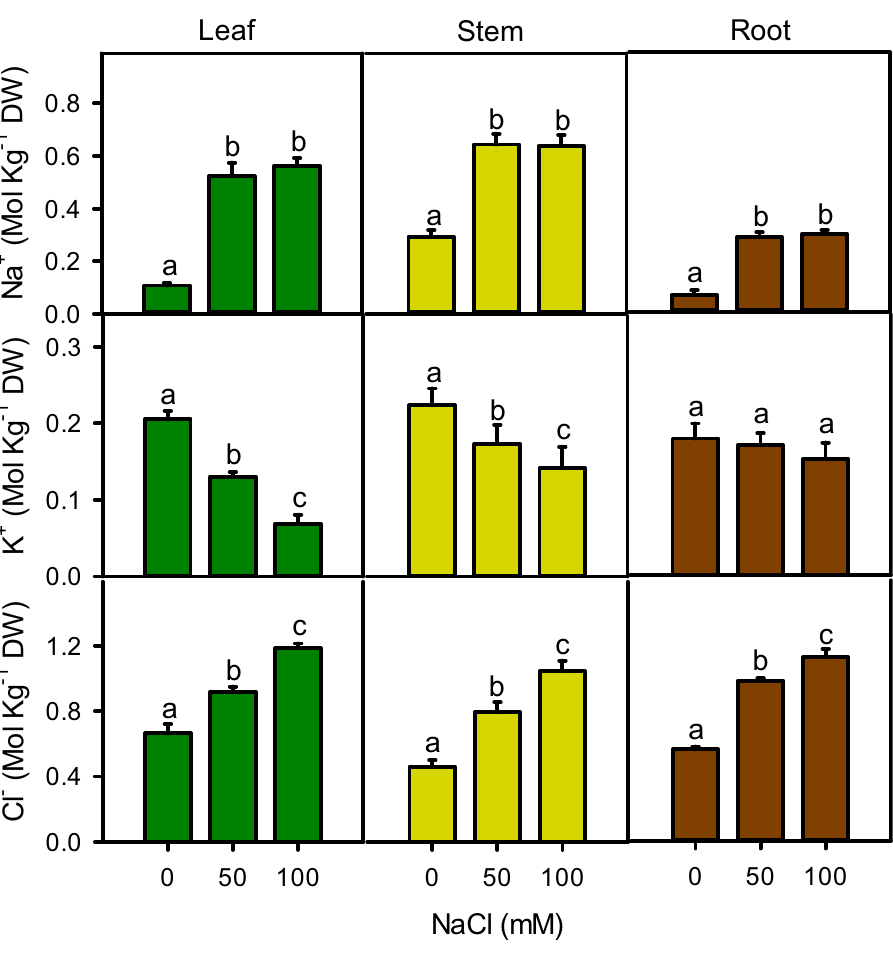
Figure 5. Contents of Na + , K + , and Cl − in different parts of Moringa under different salinity treatments. Different letters indicate significant differences at P < 0.05.